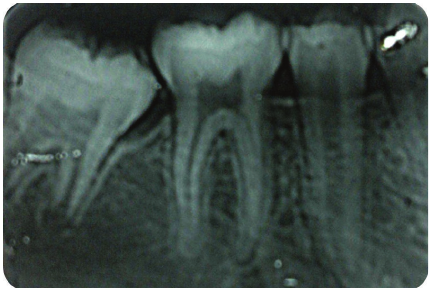
Figure 5: Intraoral periapical radiograph after 3 days with elastic placed.